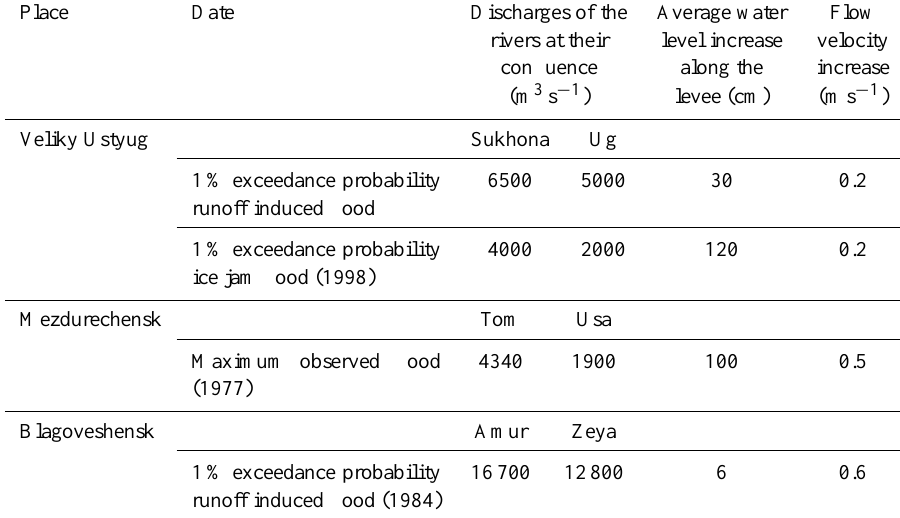
Table 2. Results of simulation of levee impact. Place Date Discharges of the Average water Flow rivers at their level increase velocity confluence along the